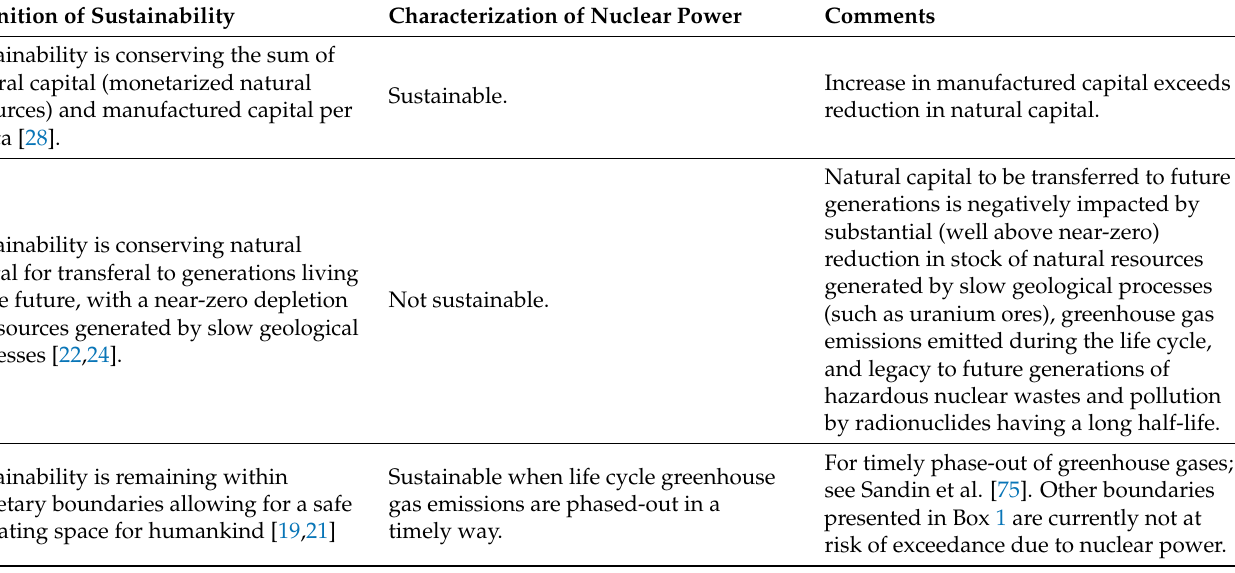
Table 1. The sustainability of nuclear power using three definitions of